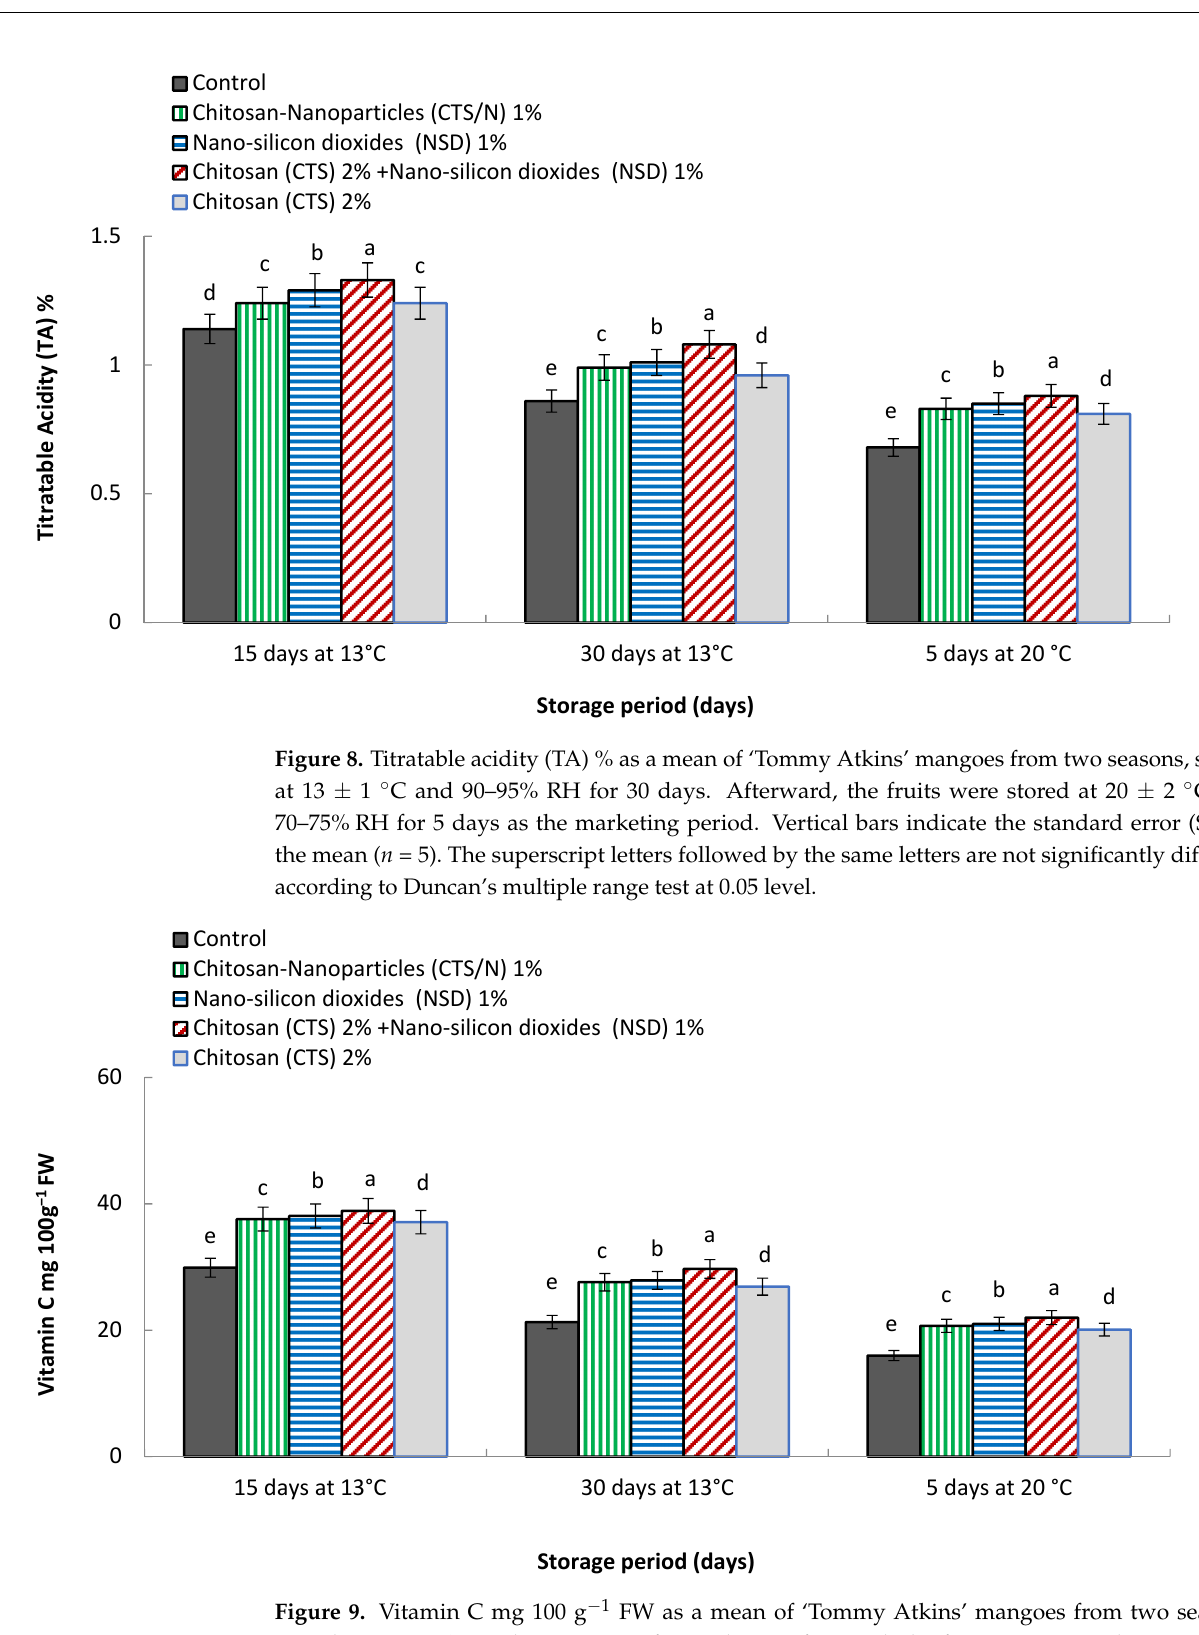
Figure 9. Vitamin C mg 100 g − 1 FW as a mean of ‘Tommy Atkins’ mangoes from two seasons, stored at 13 ± 1 °C and 90–95% RH for 30 days. Afterward, the fruits were stored at 20 ± 2 °C and 70–75% RH for 5 days as the marketing period. Vertical bars indicate the standard error (SE) of the mean ( n = 5). The superscript letters followed by the same letters are not significantly different according to Duncan’s multiple range test at 0.05 level.